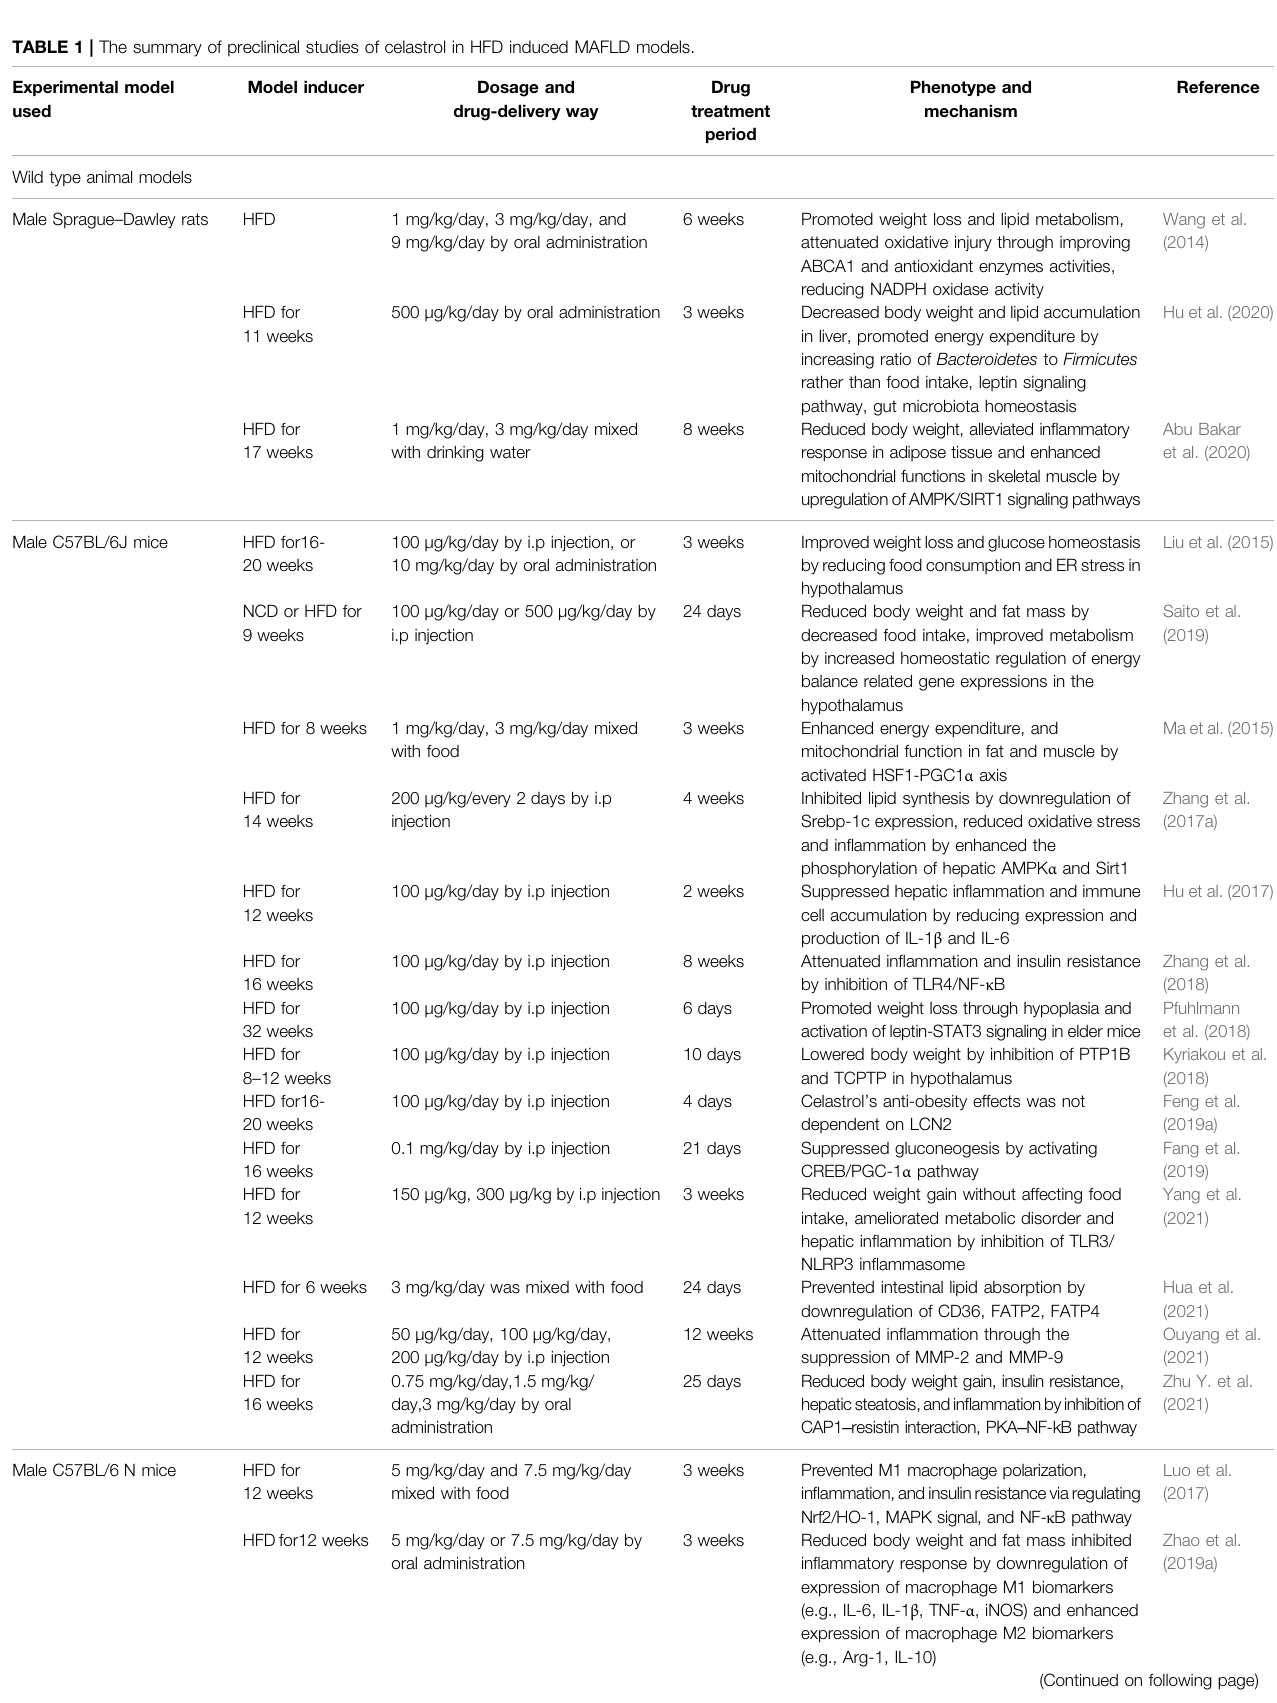
TABLE 1 | The summary of preclinical studies of celastrol in HFD induced MAFLD models. Experimental model